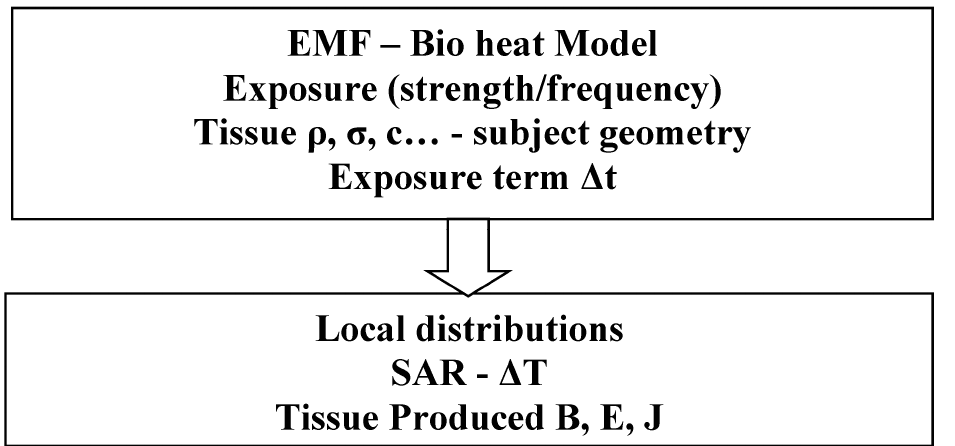
Figure 4. Schematic of modeling of exposure involving the model, input parameters and local distributed outputs.